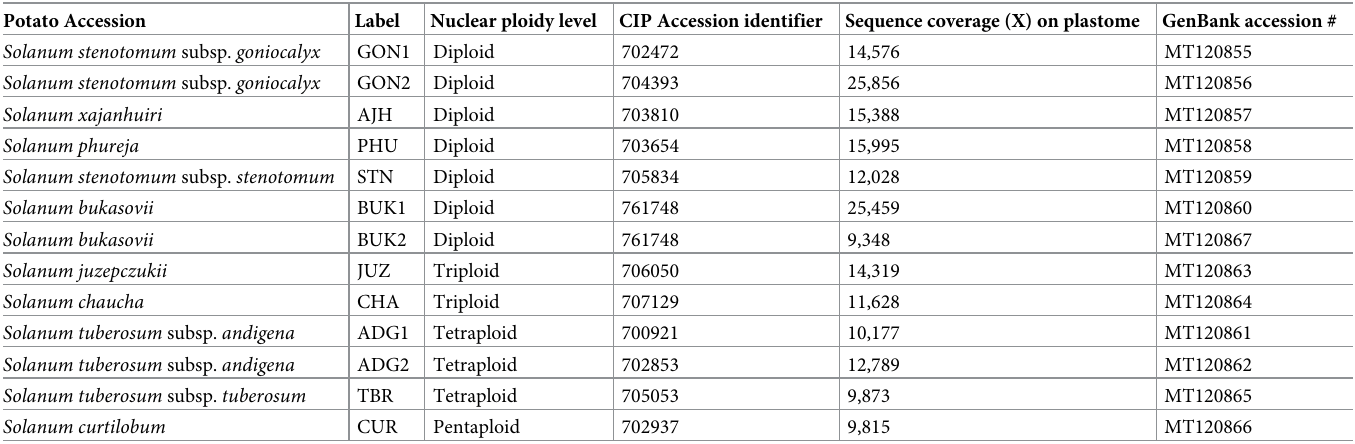
Table 1. A panel of 13 potato